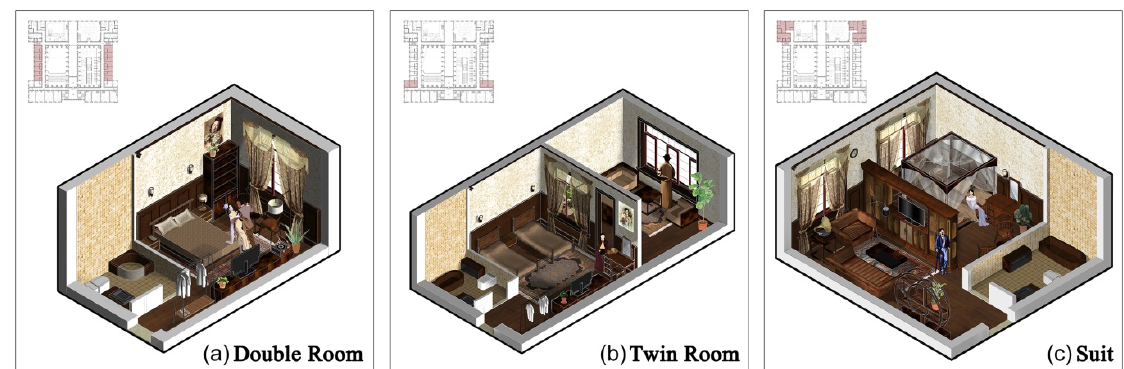
Figure 21. Analysis of Adaptive Reuse of the Former East Trading Halls.